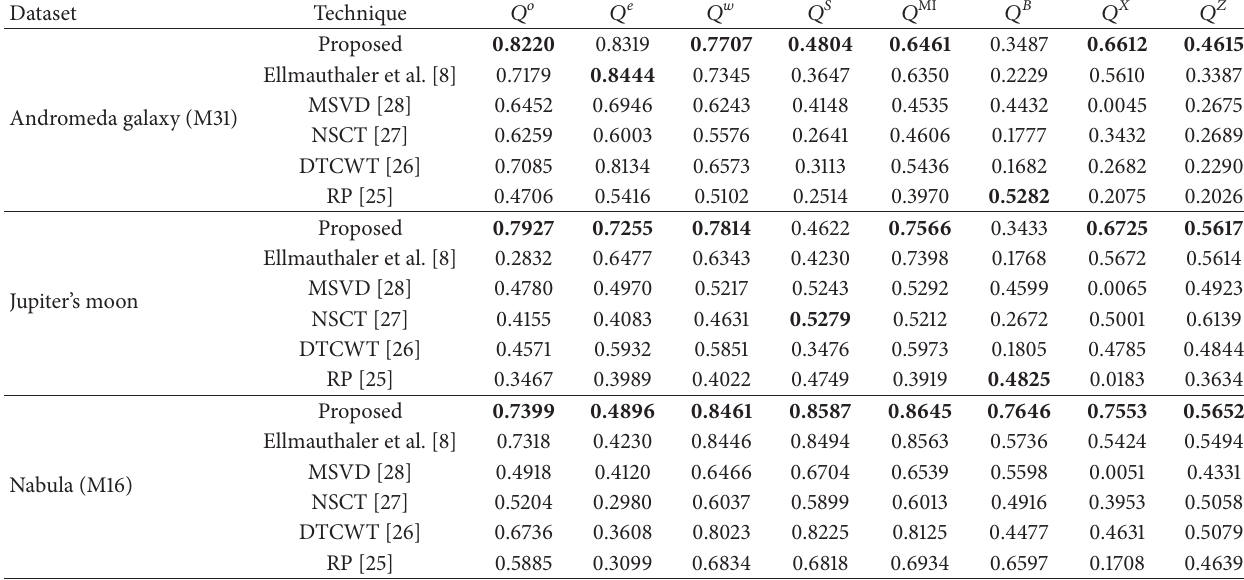
Table 1: Quantitative